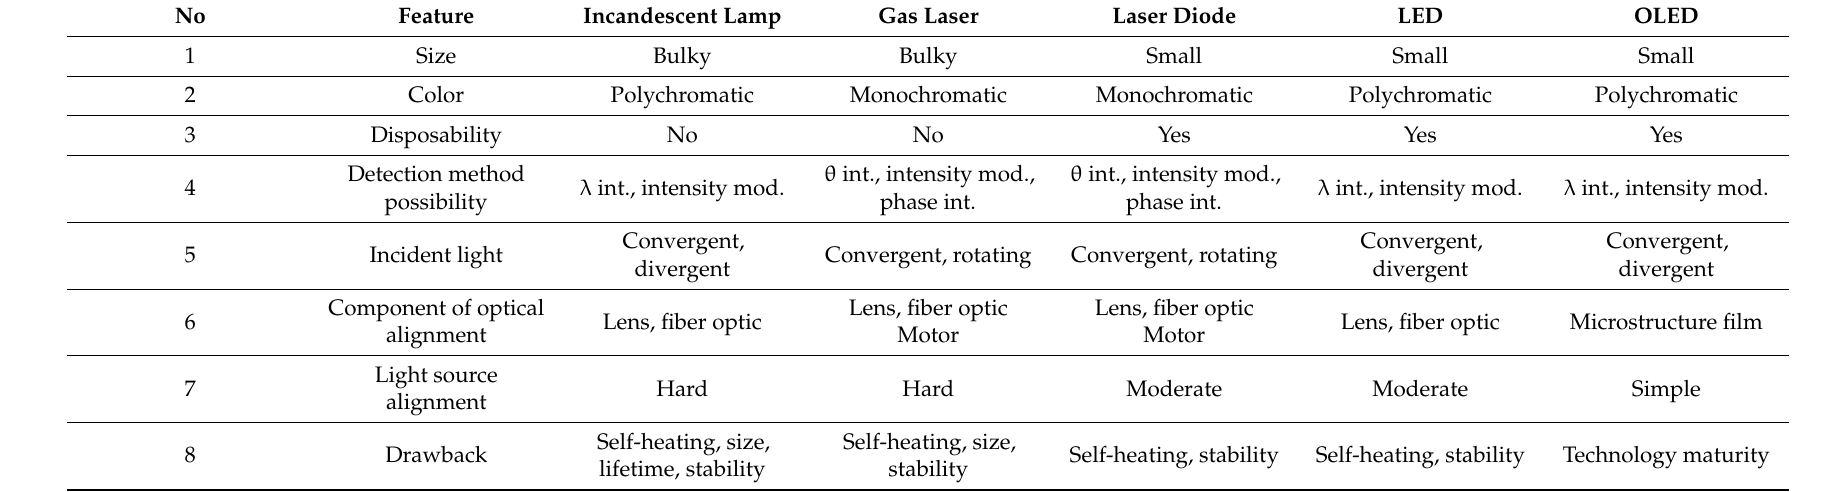
Table 1. Light source features and their implementation in SPR sensor